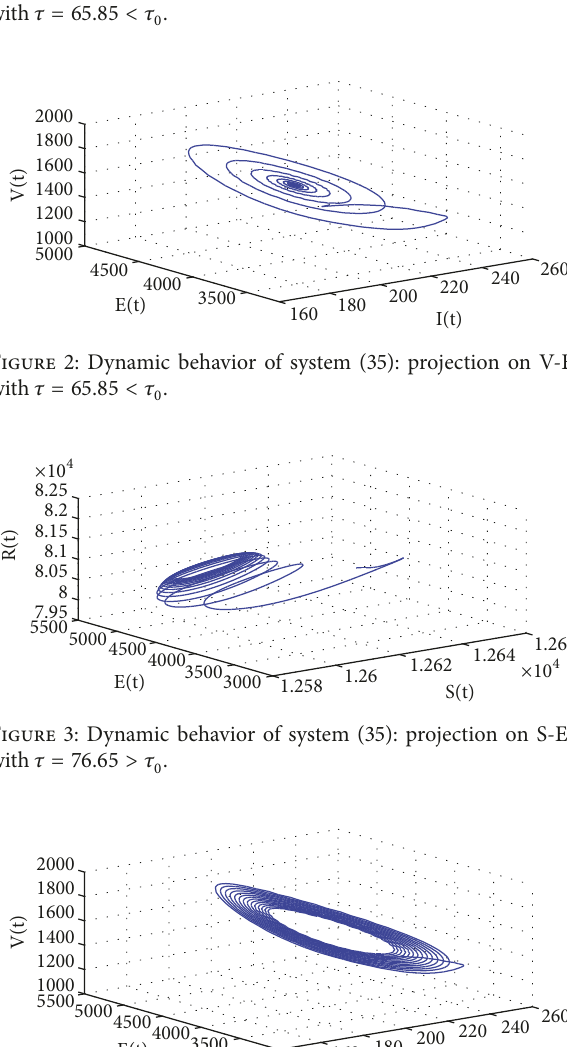
Figure 1: Dynamic behavior of system (35): projection on S-E-R with 𝜏 = 65.85 < 𝜏 0 .